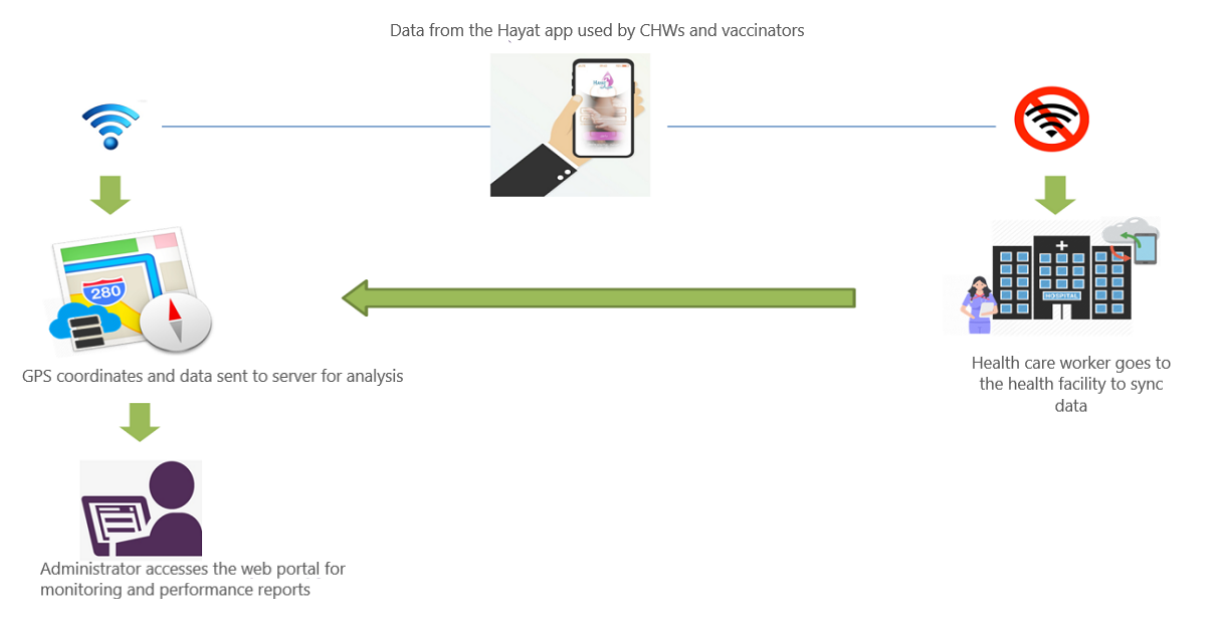
Figure 2. Workflow of the Hayat app for health managers. CHW: community health